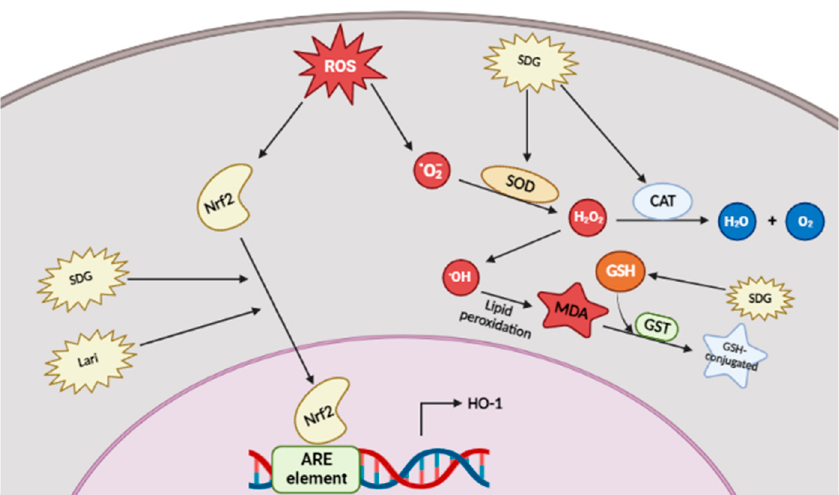
Figure 3. Antioxidant properties of lignans. Intracellular radical scavenging process can be stimulated by SDG by enhancing the expression of SOD and CAT as well as MDA reduction. Lari and SDG target Nrf2-mediated expression of HO-1.